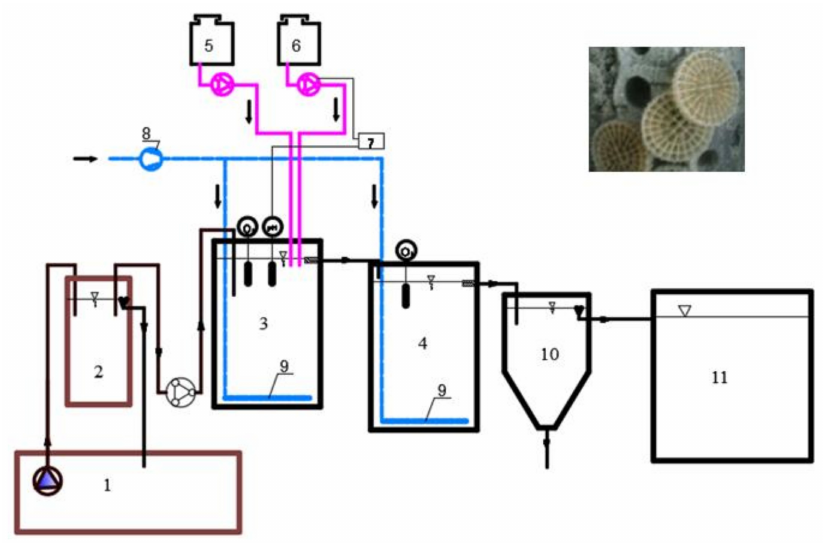
Figure 1. Scheme of MBBR and a photograph of Kaldnes K5 carriers. Legend: 1—equalization tank (350 m 3 ); 2—bu ff er tank; 3—MBBR unit-1st stage; 4—MBBR unit-2nd stage; 5—urea